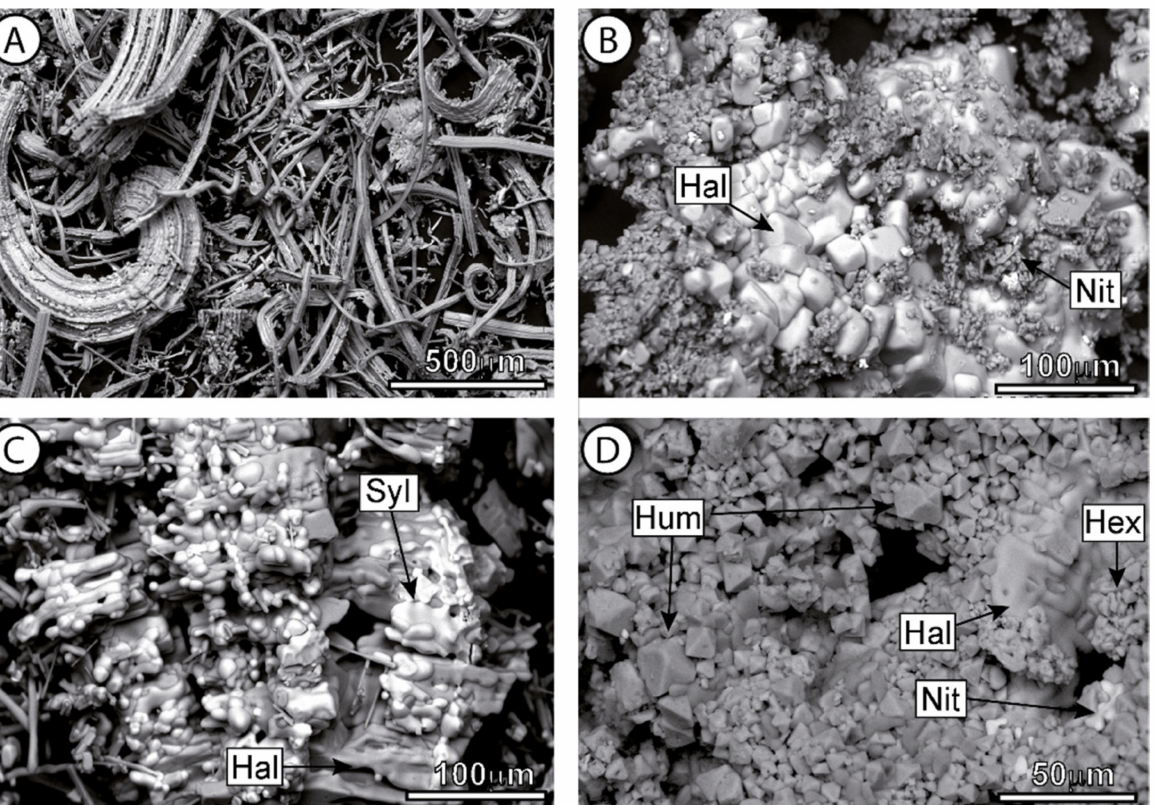
Figure 6. SEM microphotographs of salt forms from rising capillary salty waters: needle-like crystals of halite ( A ); dissolution shapes of niter ( B , D ), sylvite ( C ), and halite ( B – D ); dissolution and/or dehydration forms of hexahydrite ( B , C ); isometric shape of humberstonite ( D ). Hal: halite, Syl: sylvite; Hex: hexahydrite; Nit: niter; Hum: